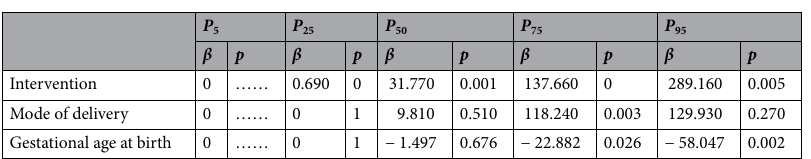
Table 3. The quantile regression analysis of the influencing factors of salivary sIgA in the two groups on the 7th day after birth. P5 5th percentile of sIgA concentration, P25 25th percentile of sIgA concentration,